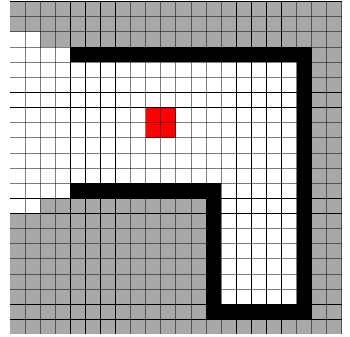
Figure 2. 2D grid-based map of occupancy.